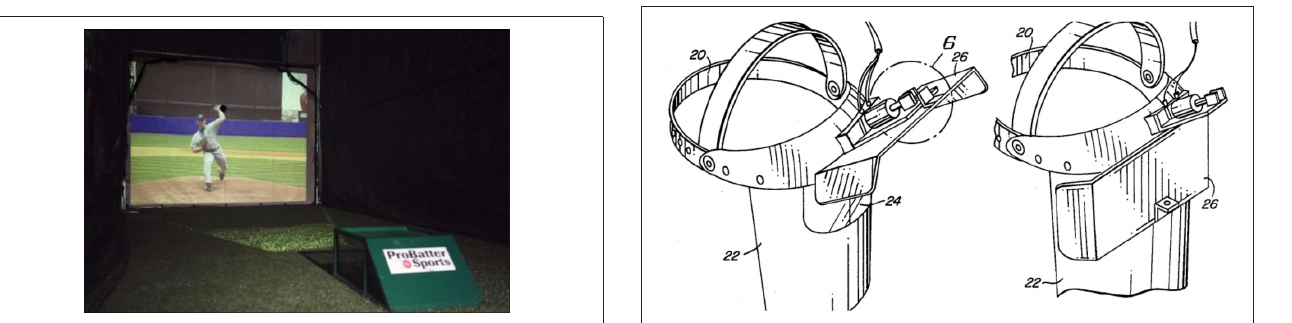
FIGURE 4 | Video pitching machine (courtesy ProBatter).